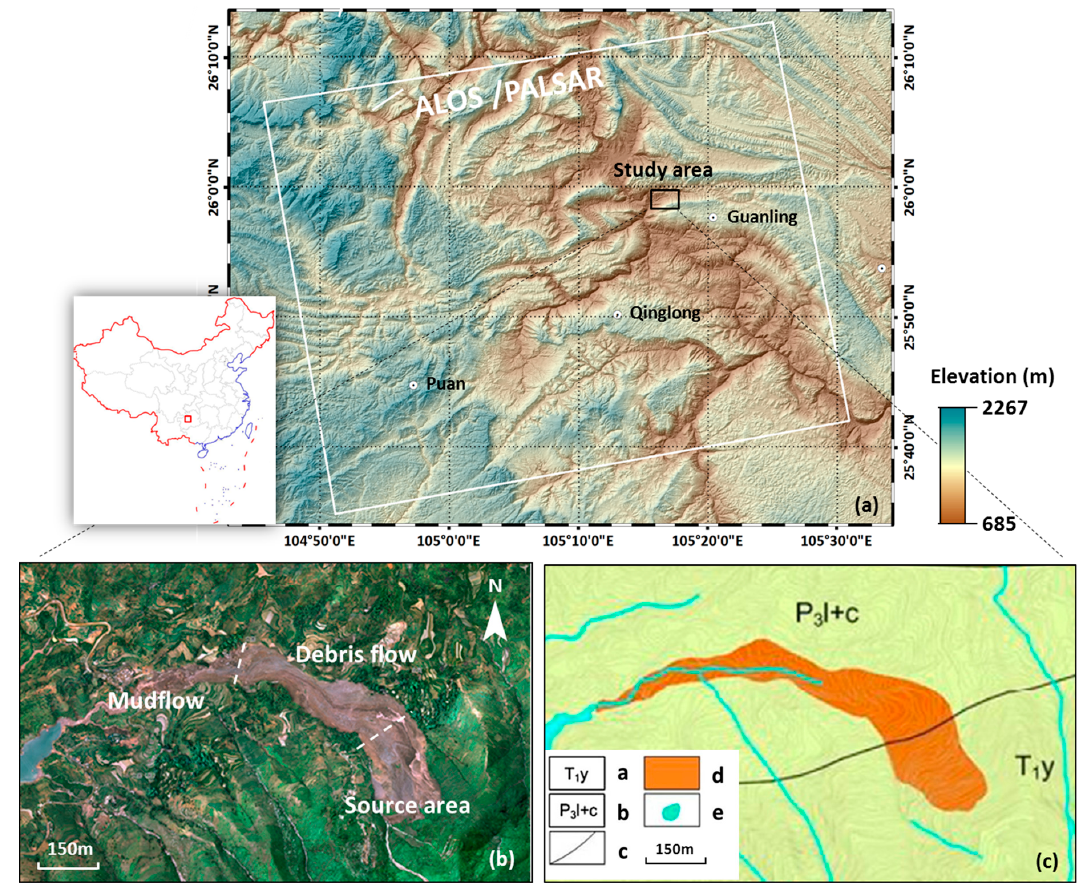
Figure 1. Research region and SAR data coverage. ( a ) Location and topography of the Guanling landslide, where the inset shows the location of the research region in China; ( b ) Aerial photogrammetry image after the landslide occurrence (modified after Tong, 2010, [2]); ( c ) Geological map of the study area, where a: Early Triassic Yelang sandstone; b: Late Permian Longtan sandy shale; c: stratigraphic boundary; d: landslide area; e: hydrographic net (modified after Xing, 2013, [17]).